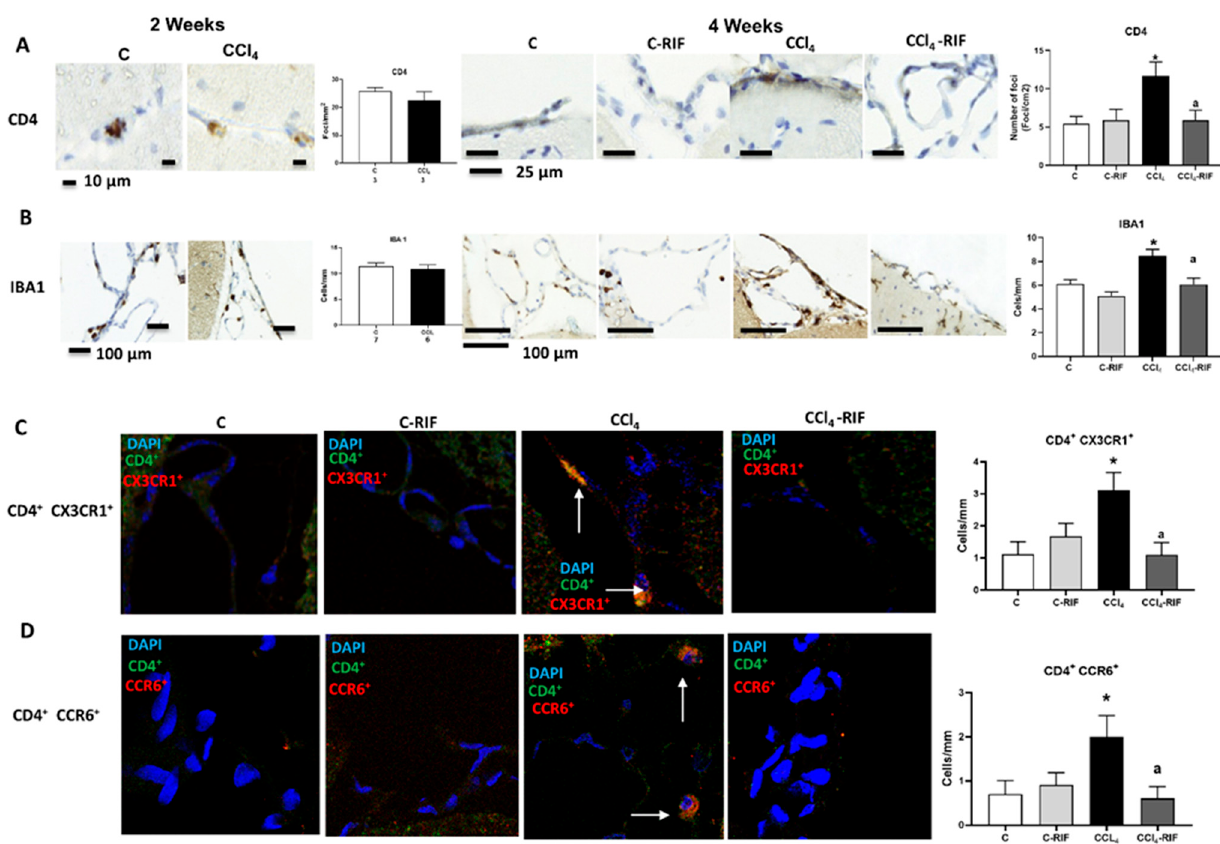
Figure 5. Rats with mild liver damage show immune cells infiltration in cerebellum at 4 weeks, which is prevented by rifaximin. Analysis of immune cells infiltration in cerebellum was performed at 4 weeks by immunohistochemistry using antibodies against ( A ) CD4, a marker of T lymphocytes (F(3,8) = 4.511, p < 0.01) and ( B ) IBA1, a marker of meningeal and perivascular macrophages (K-W(4,10) = 27.76, p < 0.0001). ( C ) Double immunofluorescence with anti-CD4 and anti-CX3CR1 as markers of autoreactive CD4 + CD28 − T lymphocytes was performed and quantified (K-W(4,5) = 8.711, p < 0.05). ( D ) Double immunofluorescence with anti-CD4 and anti-CCR6 as marker of Th17 lymphocytes was performed and quantified (K-W(4,7) = 8.858, p < 0.05). Number of animals in each group was added under group names. One-way ANOVA with Tukey’s test (CD4 + ) and nonparametric Kruskal–Wallis (K-W statistic) with Dunn’s test (Iba1, CD4 + /CX3CR1 + and CD4 + /CCR6 + ) was performed to compare all groups. Values significantly different from control rats are indicated